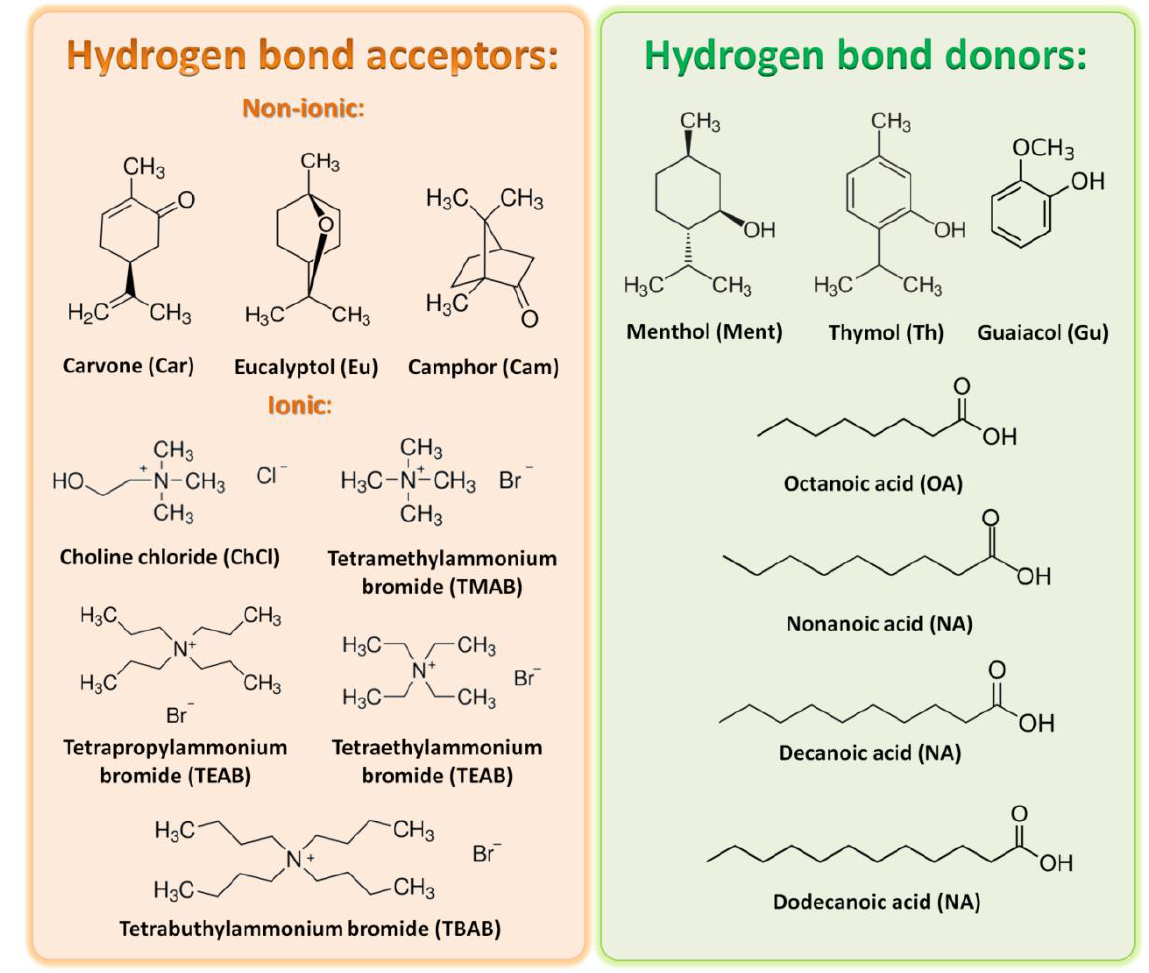
Figure 2. Structures of HBA and HBD used for the COSMO-RS solubility prediction.